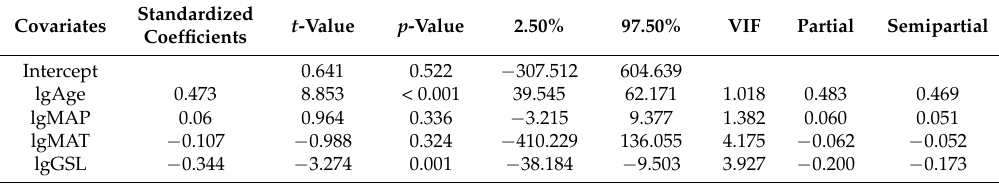
Table 3. Multiple regression fits to a global compilation of data from 262 woody plant communities. Covariates